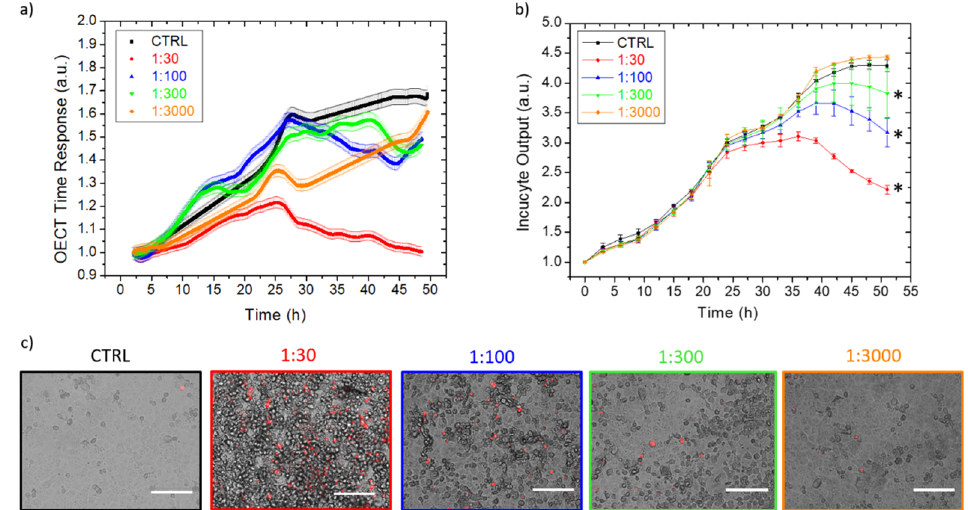
Figure 5. The OECT ( a ) and Incucyte ® ( b ) real-time monitoring of VERO E6 cells, infected with progressively diluted EMCV, compared to healthy cell growth, as the control. Each OECT time response point is the average of five consecutive measurements, having the standard deviation reported as the curve shadow. ( c ) The optical micrographs on the active area of the devices after 48 h of EMCV incubation at different dilutions and the control over a standard healthy growth, using a red staining dye for dead cells. * p < 0.05 denotes a significant difference compared to the control.